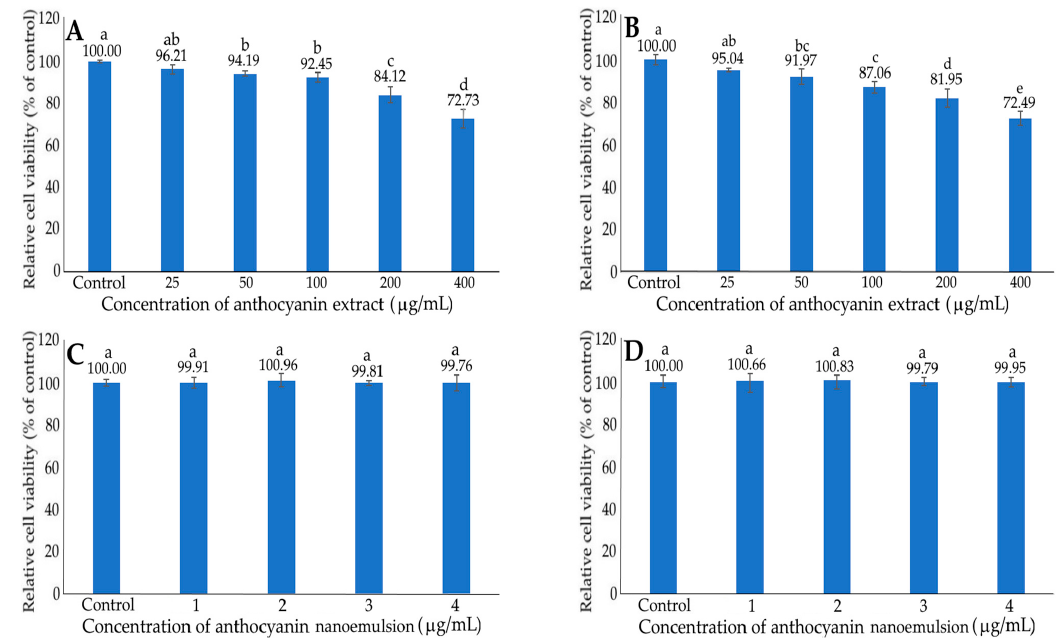
Figure 7. Effect of different concentrations of anthocyanin extract ( A , B ) and nanoemulsion ( C , D ) on the growth of liver normal cells AML12 ( A , C ) and liver cancer cells HepG2 ( B , D ) after 48 h incubation as measured by MTT assay. Data shown are mean ± standard deviation (n = 3) and data with different small letters (a–e) are significantly different at p < 0.05.